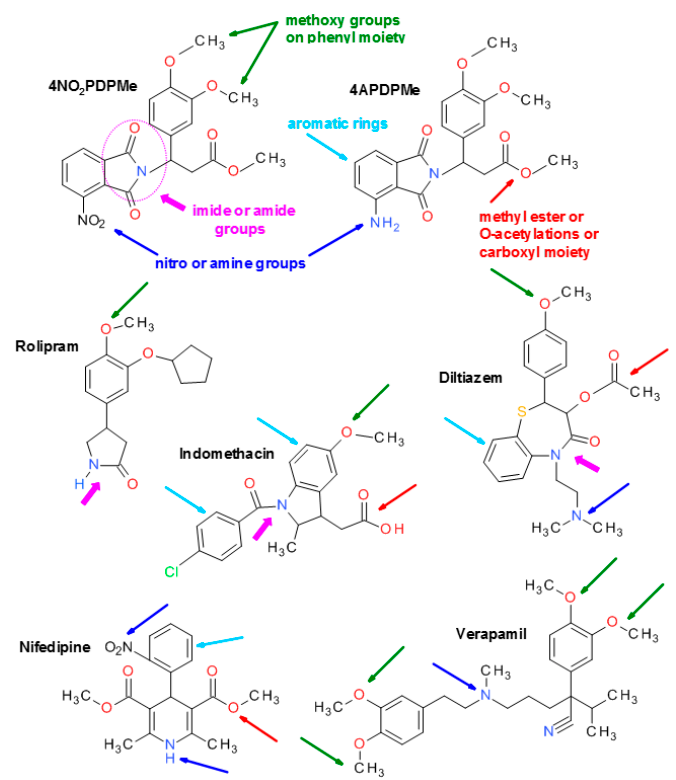
Figure 7. Chemical structures of thalidomide analogs and rolipram in comparison to some known Ca 2+ -channel blockers. All of them displayed a variety of similar moieties such as a dialkoxyphenyl group (methoxy or other O -alkyl substituents), nitro, imide and amide groups, a carboxyl moiety or its derived methyl ester as well as O -acetylation. Similar moieties are indicated by arrows and/or dashed lines in different colors.